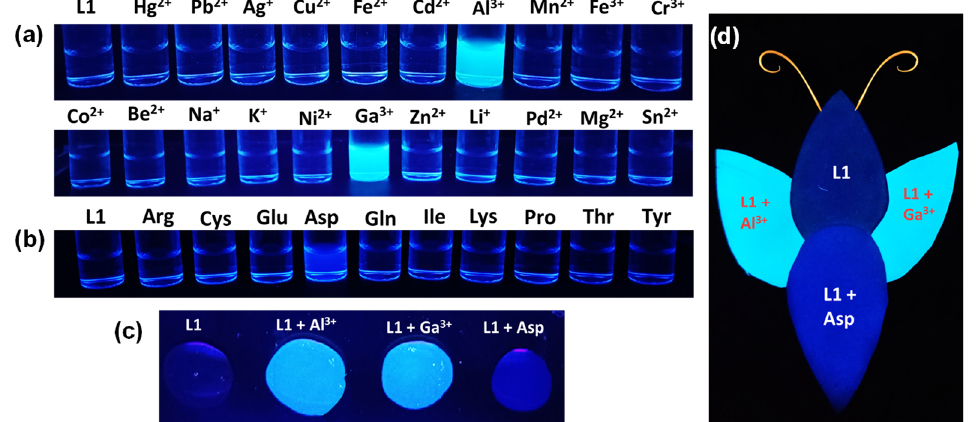
Figure 14. Optical images of chemosensor L1 ( a ) with different metal ions (2.5 equiv.) and ( b ) amino acids (2.5 equiv.) in solution state; ( c ) polystyrene films loaded with L1 in the absence and presence of Al 3+ and Ga 3+ ions and Asp. ( d ) Filter paper test strips of L1 in the absence and presence of Al 3+ and Ga 3+ ions and Asp. All images were taken under a UV lamp (λ ex = 365 nm).